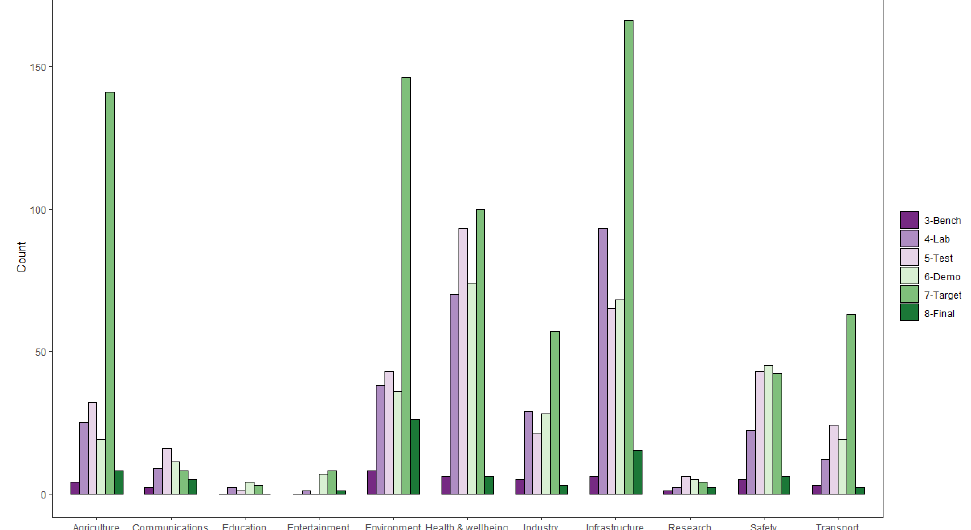
Figure 11. Deployment distribution between field of the goal network and TRL. Most of the deployments where the subject of the goal network is a friendly actor are related to range from TRL4 to TRL6, which matches a normal distribution. On the other hand, in the case of the environment-related deployments, the situation is opposite—most deployments are related low and high TRLs, which is inverse to normal distribution